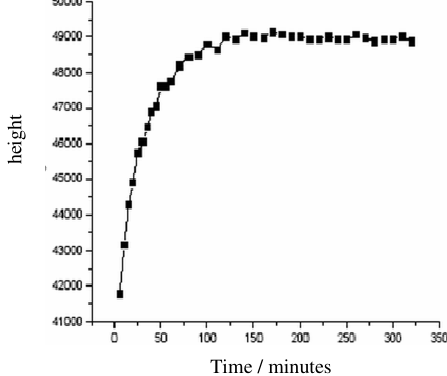
Figure 4. The rise of the sample peak height with time for the diffusion of liquid vapor ( n -hexane) into nitrogen ( v =cm 3 s- 1 ), 313.15 K and 1